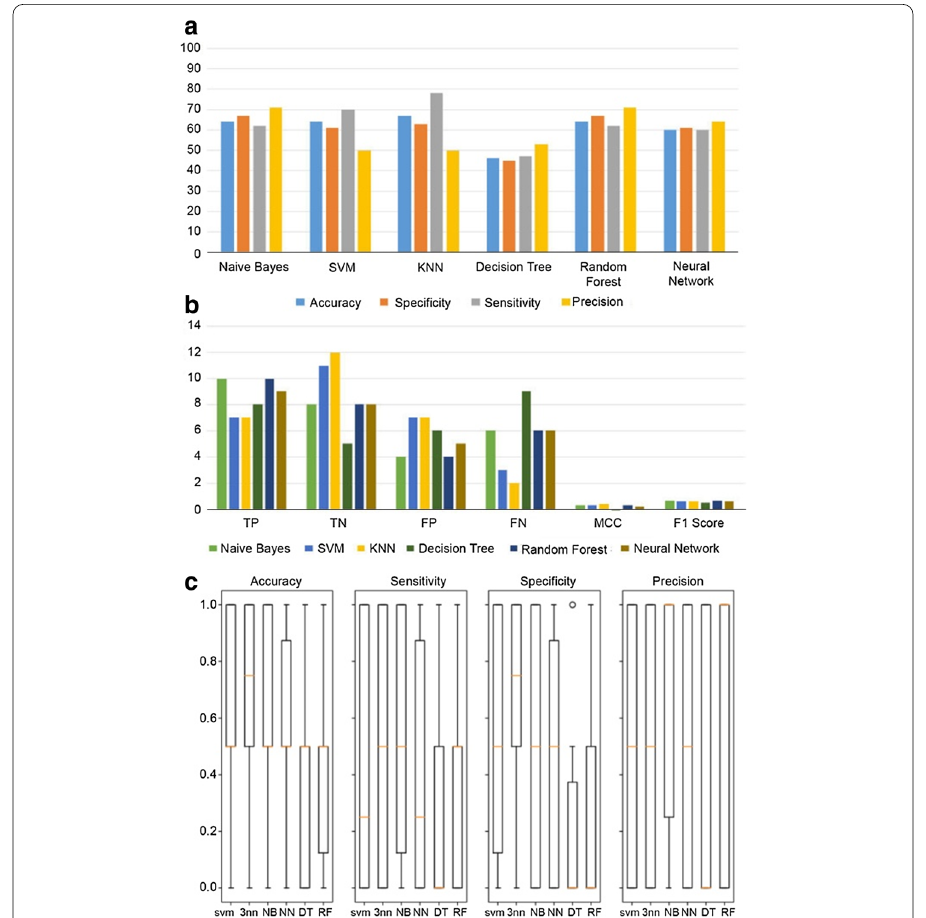
Fig. 2 Performance of the machines trained by using the reduced features extracted from the PCA algorithm. a The diagrams show averages of Accuracy, Specificity, Sensitivity and Precision criteria in 14 machine training cycles. b The diagrams show averages of TP, TN, FP, FN, MCC and F1 Scores in 14 machine training cycles. c The box plots show performances of the six proposed machines based on accuracy, sensitivity, specificity and precision